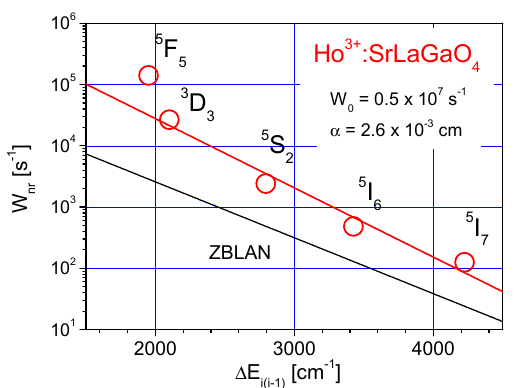
Figure 6. The multiphonon relaxation rate W nr as a function of energy gap ∆ E for the excited states of Ho 3+ ion in SrLaGaO 4 —red line. Open circles denote experimental points. For comparison the data for ZBLAN glass are also presented—blue solid line.